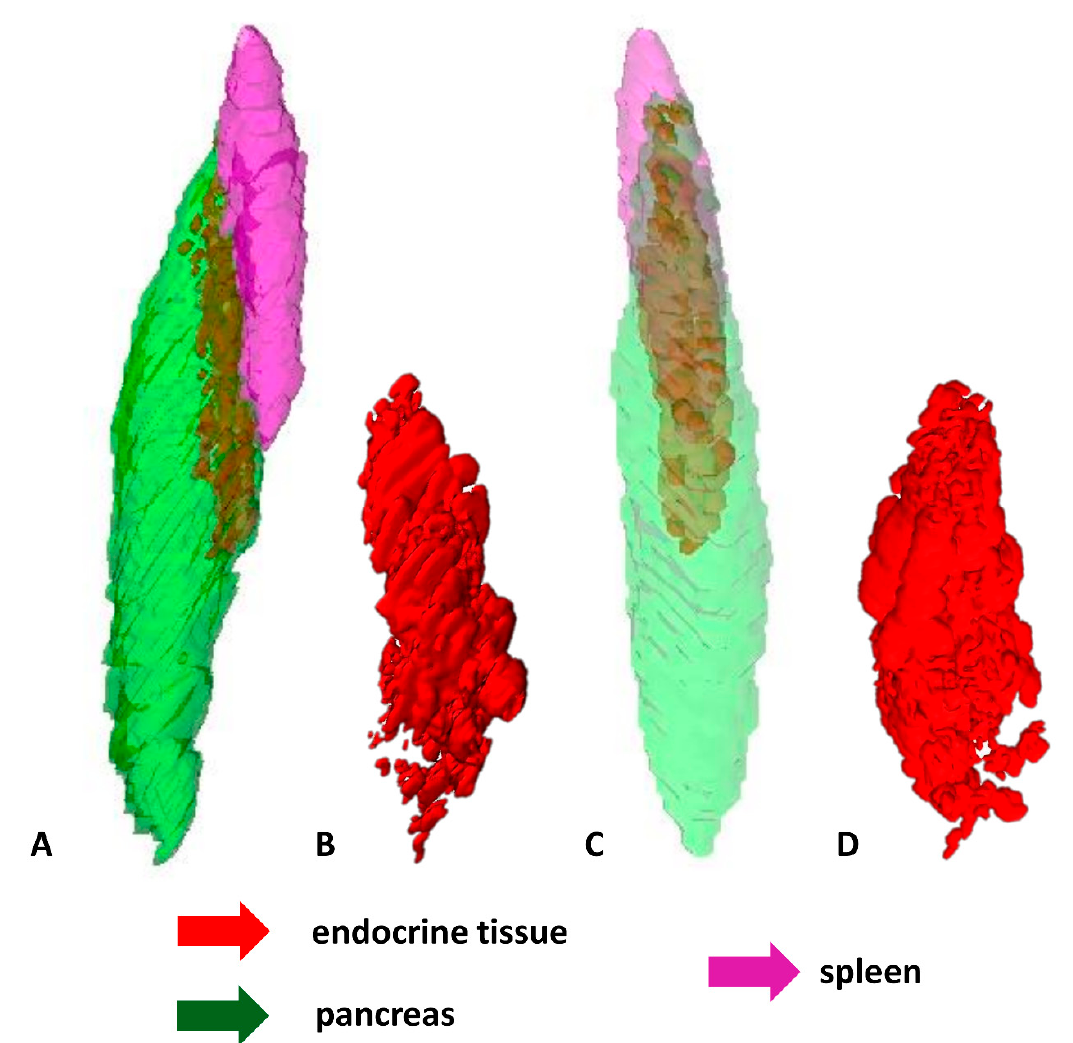
Figure 6. 3D reconstructions of the pancreatic islet arrangement within pancreas of the grass snake embryos at developmental stages IV–VIII. Note large agglomerate of endocrine tissue. ( A ) Lateral view. Pancreas with spleen visualized. ( B ) Lateral view on pancreatic islets. ( C ) Anterio-lateral view. ( D ) Anterio-lateral view on pancreatic islets.